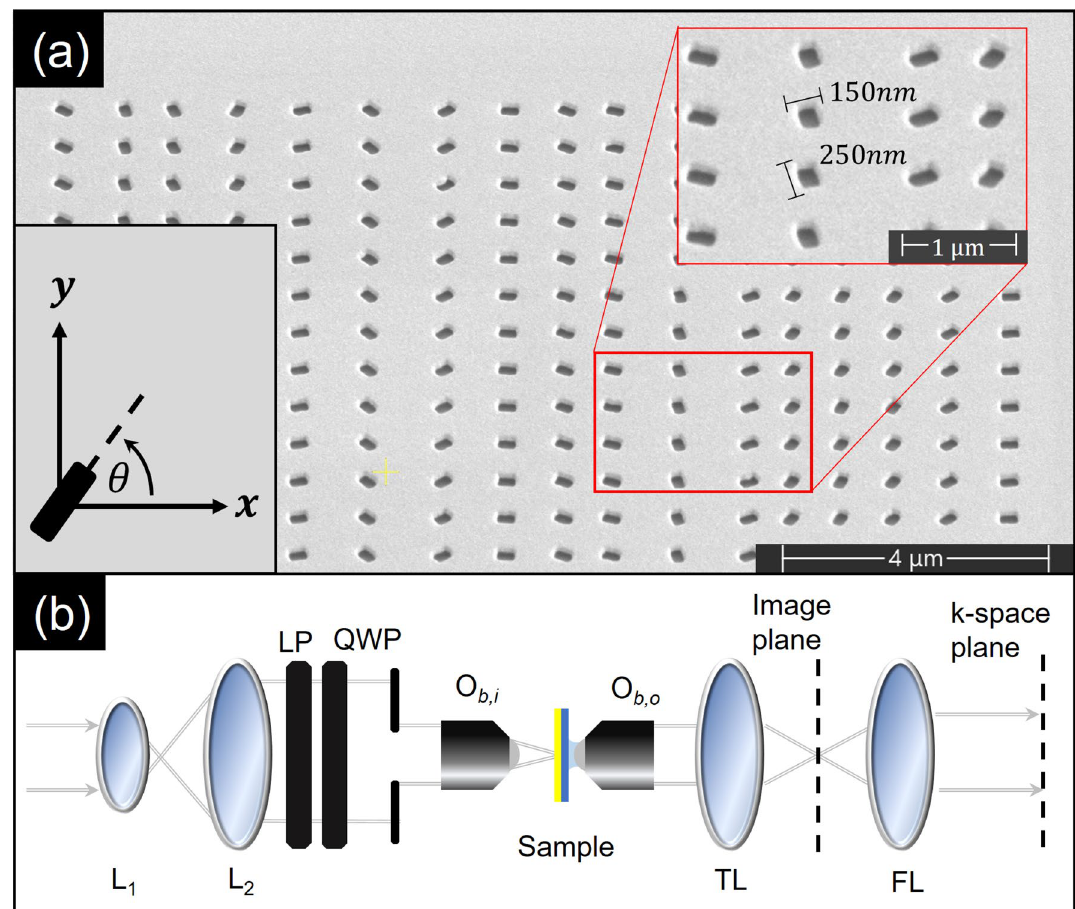
Figure 2. Randomized topological plasmonic structure. ( a ) SEM image of FIB milled apertures in gold. The inset schematically depicts characteristic aperture dimensions and orientation variation. ( b ) Optical leakage radiation microscopy setup. See the text for the